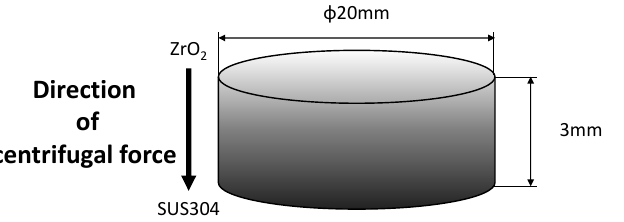
Figure 2. Schematic illustration of a sample of FGMs made by centrifugal slurry methods.